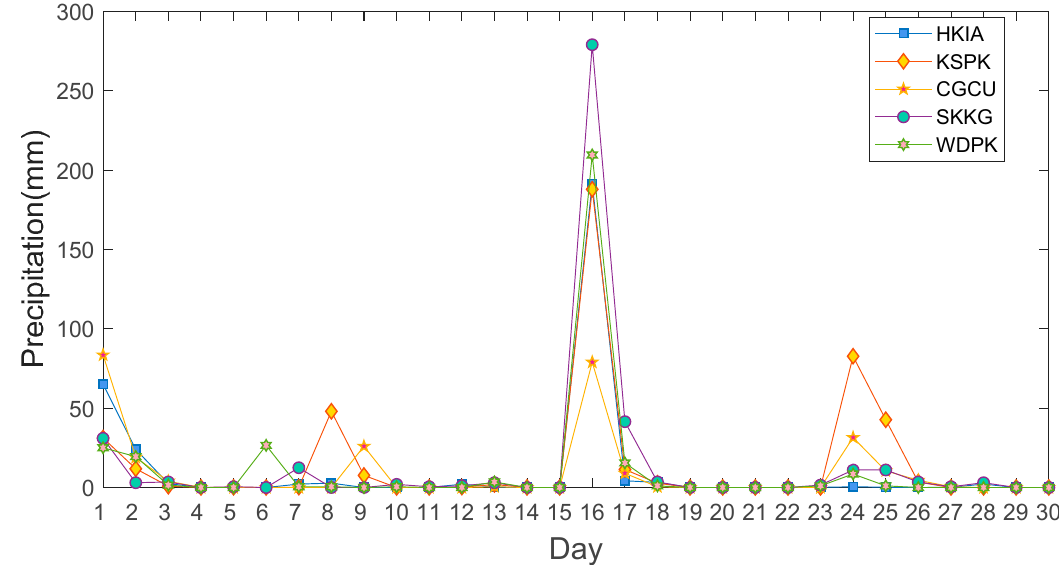
Figure 8. Daily mean precipitation over each weather station in September.